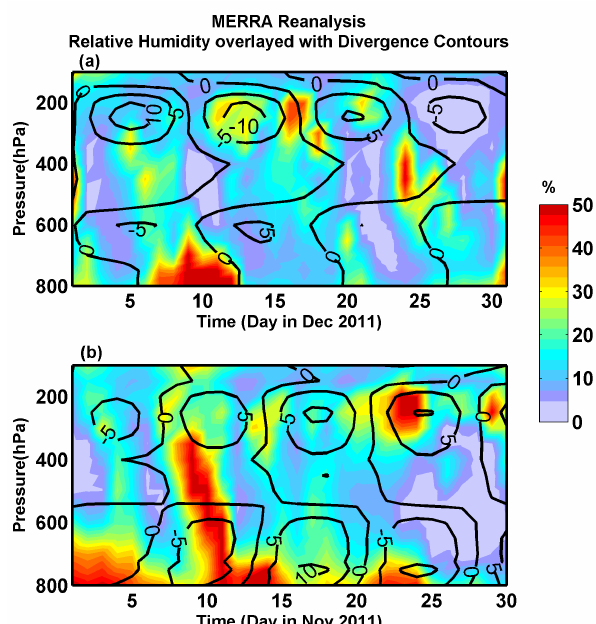
Figure 4. Panel (a) : pressure (hPa)-versus-time contour plot of rel- ative humidity (%) and overlaid divergence contours (in units of 10 − 6 s − 1 ) derived from MERRA reanalysis data (solid black lines) over the observational site between 1 and 31 December 2011. Panel (b) : same as (a) but from 1 to 30 November